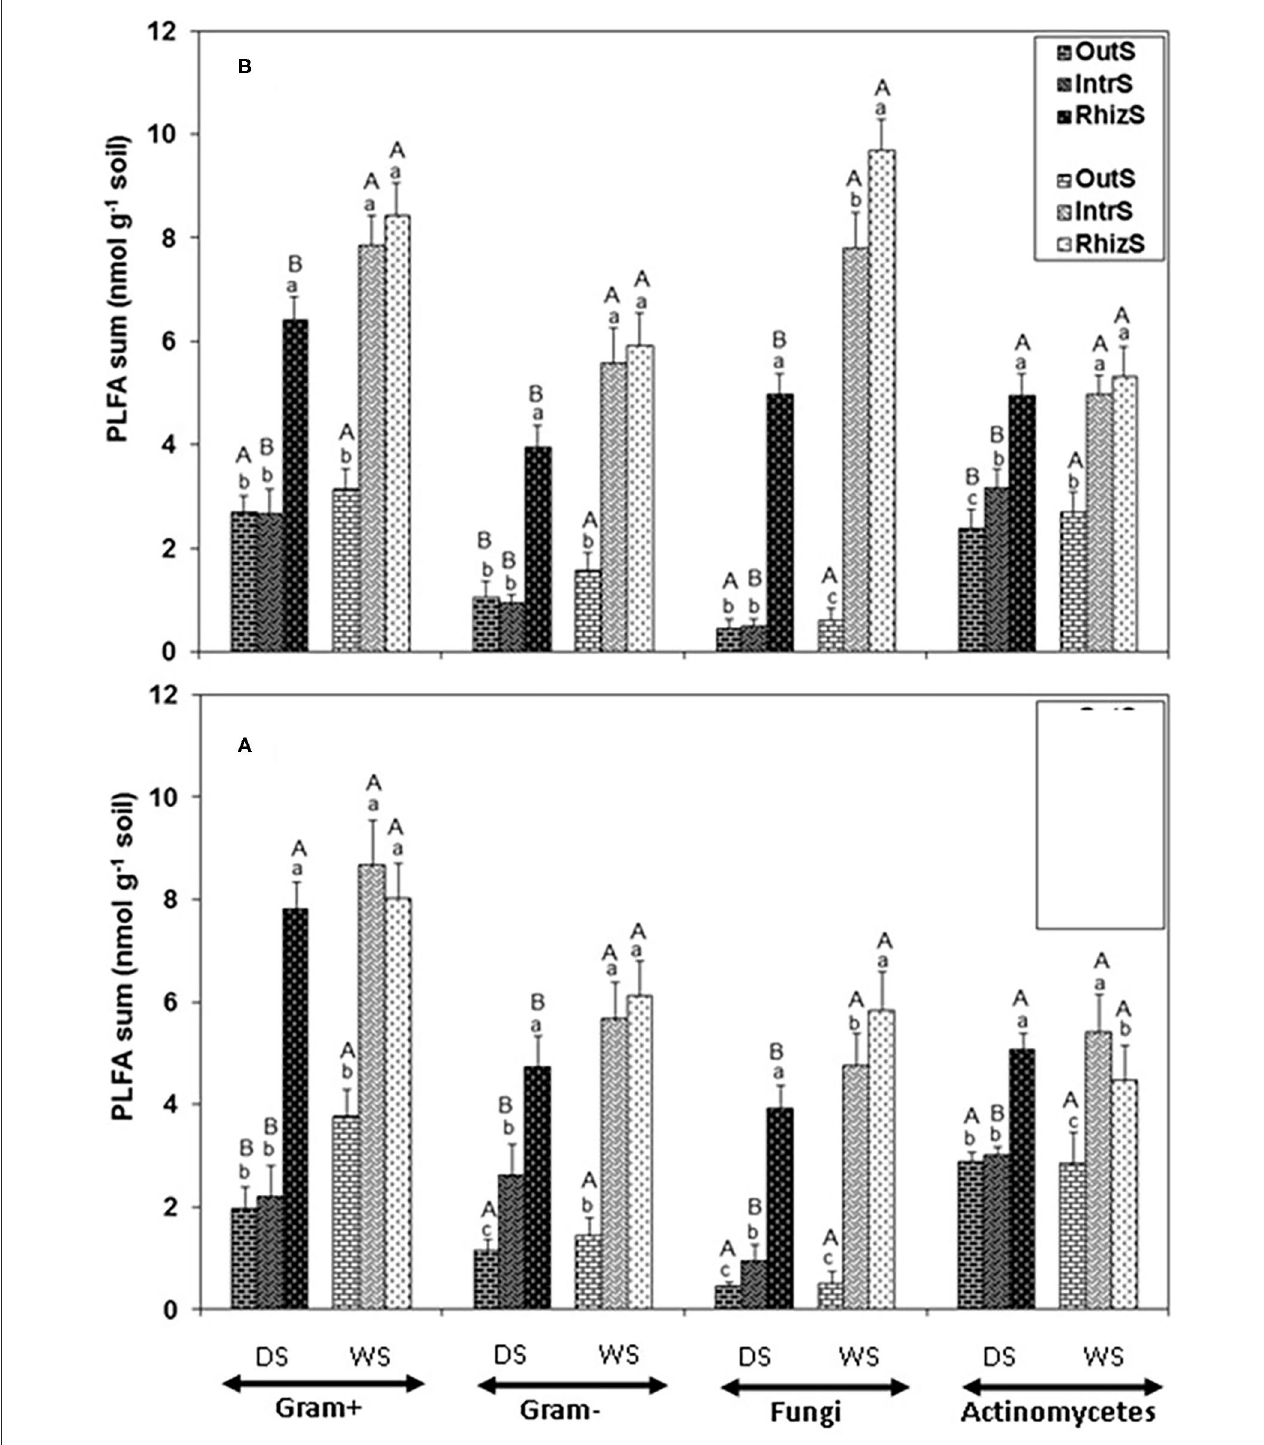
FIGURE 1 | Summation of PLFAs representing Gram + , Gram-, fungi and actinomycetes microorganisms extracted from soil associated with (A) G. senegalensis , and (B) P. reticulatum . Soil samples (RhizS, shrub rhizosphere soil; IntrS, inter-root soil; and OutS, outside the influence of shrub soil) are from the dry season (DS) and wet season (WS). Bars are standard deviations. The lower case letters represent means separation between sampling locations and upper case letters represent mean separation between seasons for the same soil location.